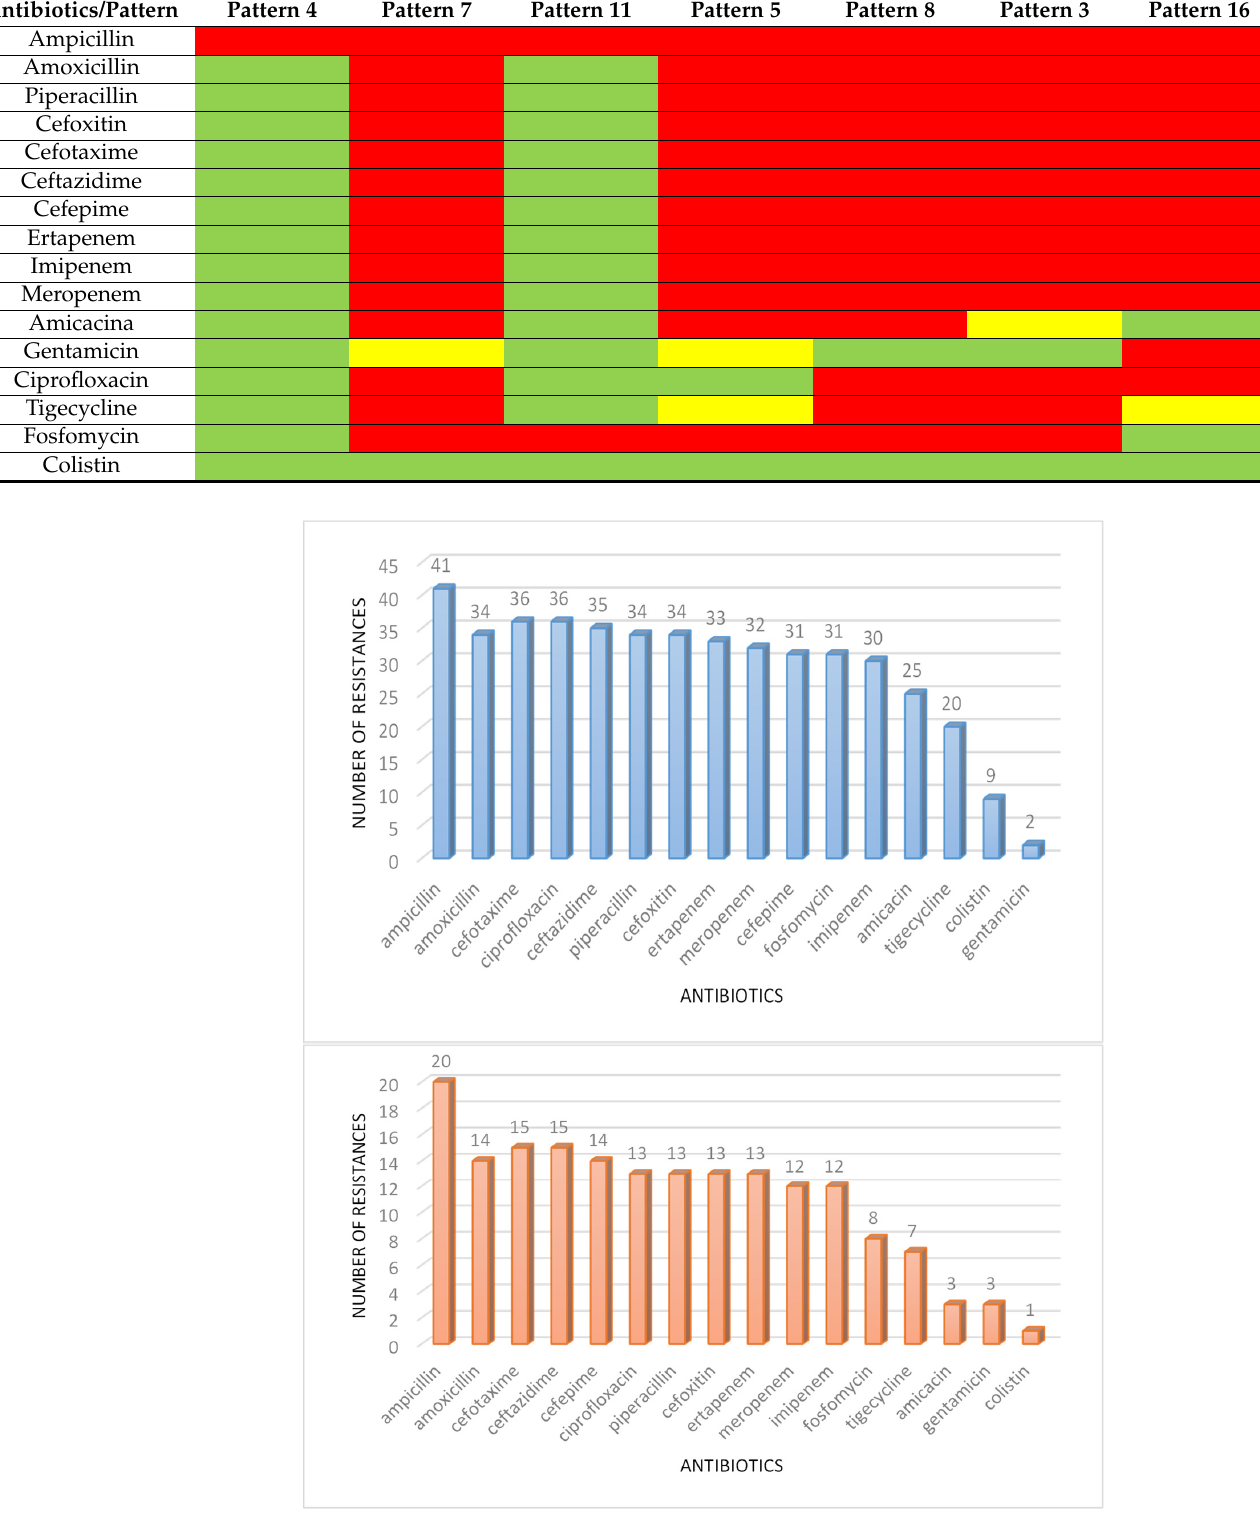
Figure 8. MDR resistance patterns in intensive care (upper plot, 42 cases) and infectious diseases (under plot, 20 cases) wards (from the database described in Section 2.2).